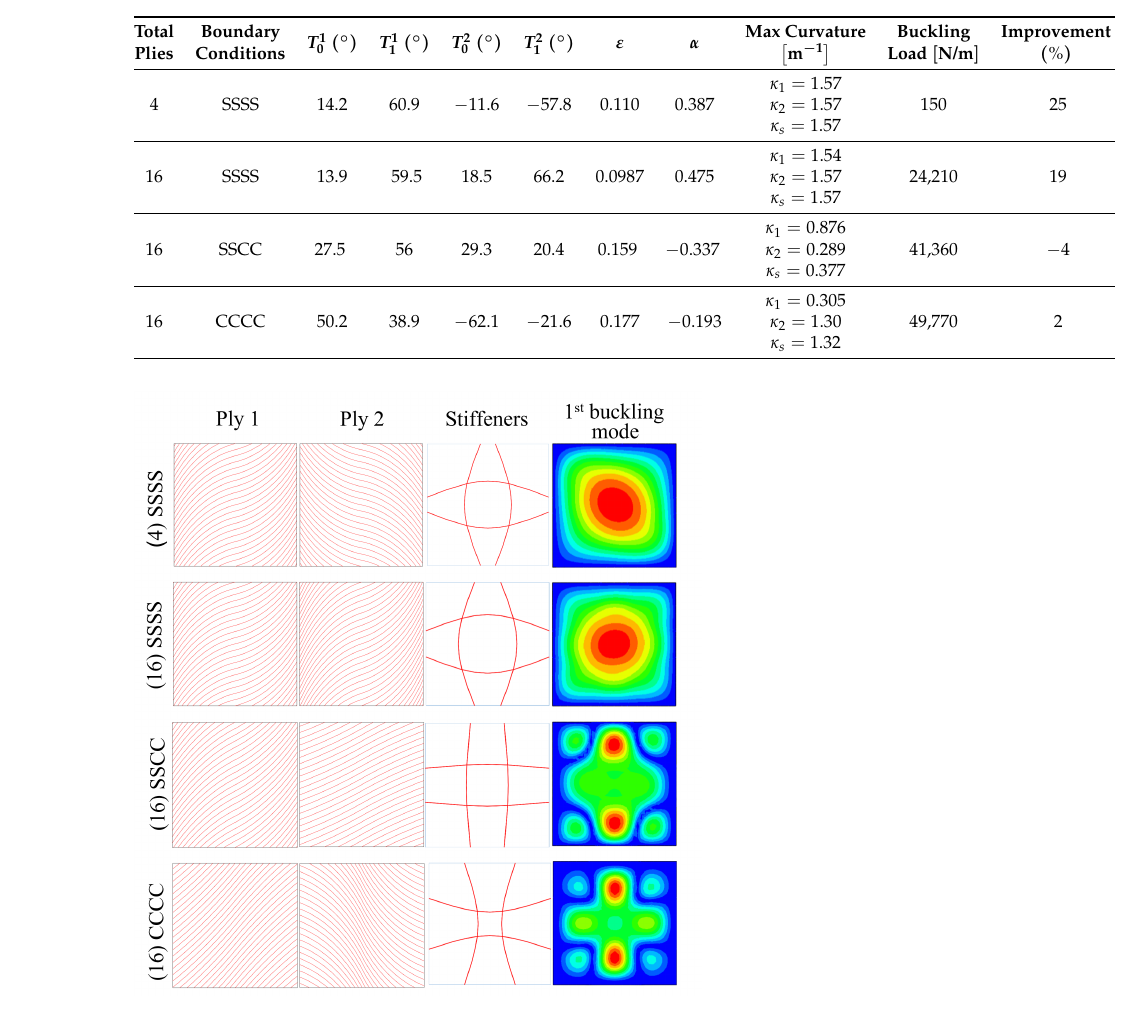
Figure 12. Optimized ideal panels subjected to biaxial compression. Table 6. Optimization results of panels considering gap effect, subjected to biaxial compression